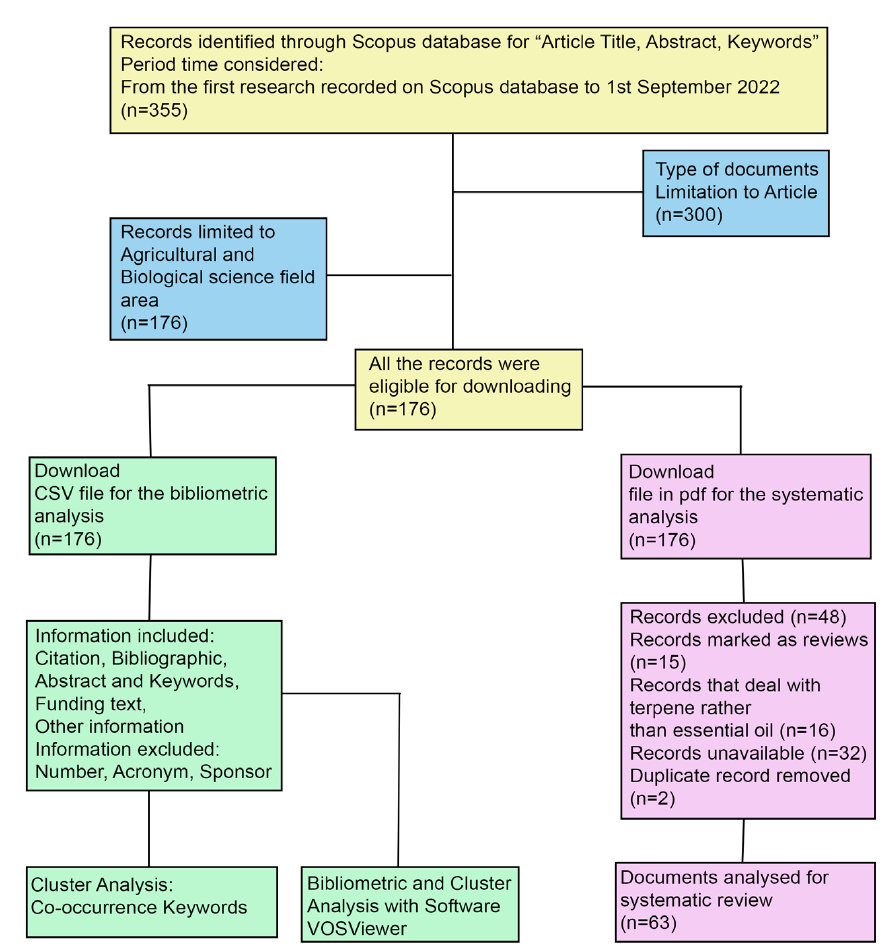
Figure 3. Flow diagram for article selection. The process highlights the number of studies identified along with exclusion and inclusion criteria. Table 1. Most significant results of the literature analysis. Each publication shows the essential oil(s) (EO) and the nematode target. Each line of the table corresponds to a single article in which significant nematicidal effects (mortality, paralysis, hatching inhibition) are reported together with the EO concentration and time exposure. The multiple “*, **, ***, ****” are used to diversify the results in each article, therefore in each table’s line, where different EOs showed results at varied concentrations. It is possible that the article is repeated as different nematodes (genus or species) might be put under